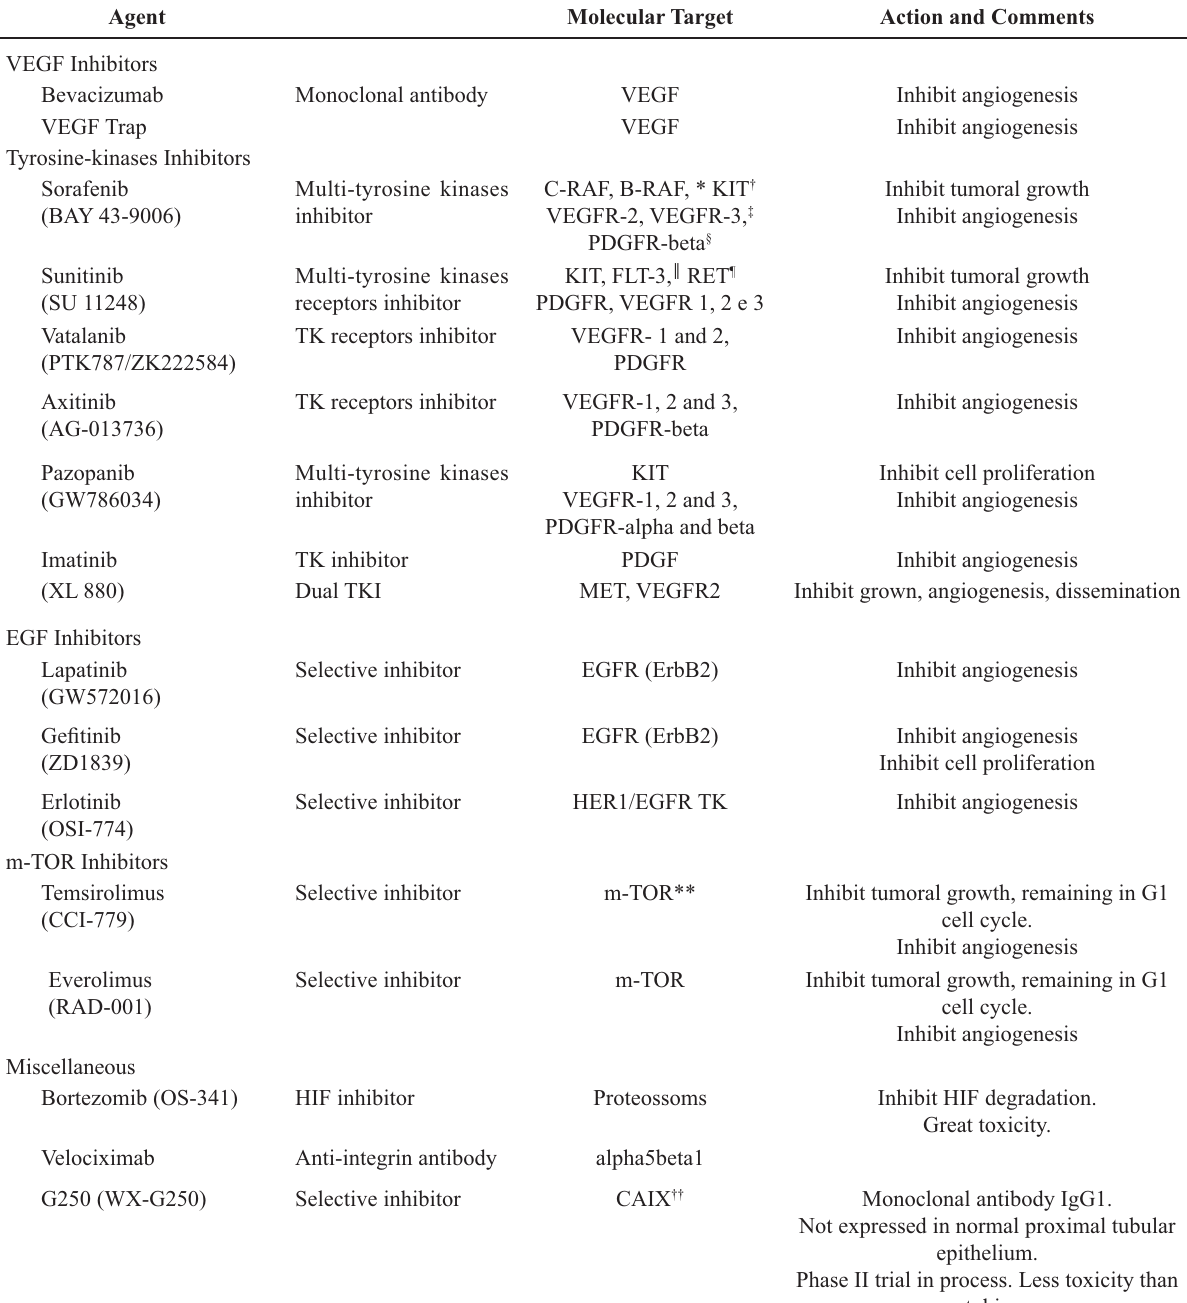
Table 2 – Novel target agents in management of metastatic renal cell